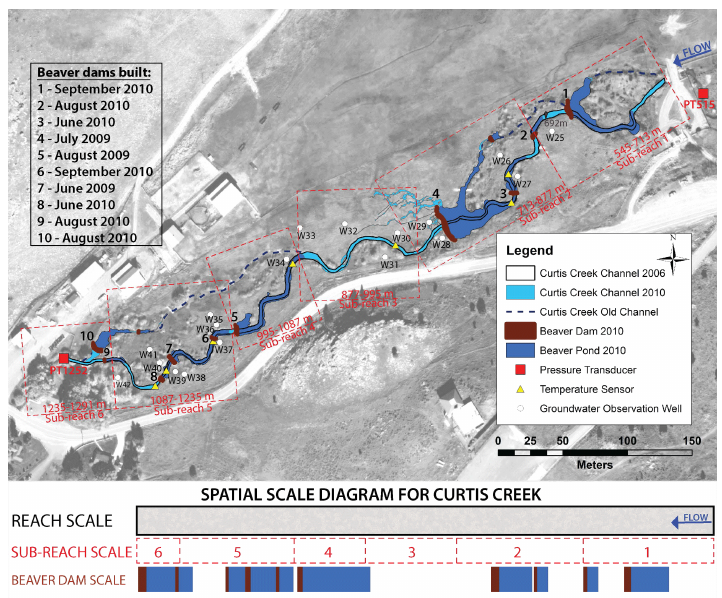
Figure 1. Aerial image from 2006 (pre-beaver period) and beaver dams constructed between 2009 and 2010. The main beaver dams are numbered 1–10 from upstream to downstream and the time of dam construction is noted in the table. The study reach was further divided into six sub-reaches. The spatial scales investigated are illustrated below the map. The most downstream beaver dam and beaver pond are located in the old channel but overlap in the beaver dam scale schematic in this figure. The 2006 channel is outlined in black, while the flowing and ponded water area from 2010 are represented by different shades of